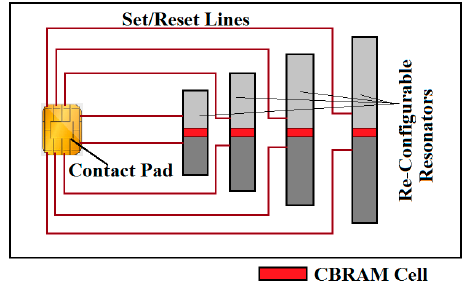
Figure 9. Conceptual illustration of an electronically reconfigurable chipless RFID tag.